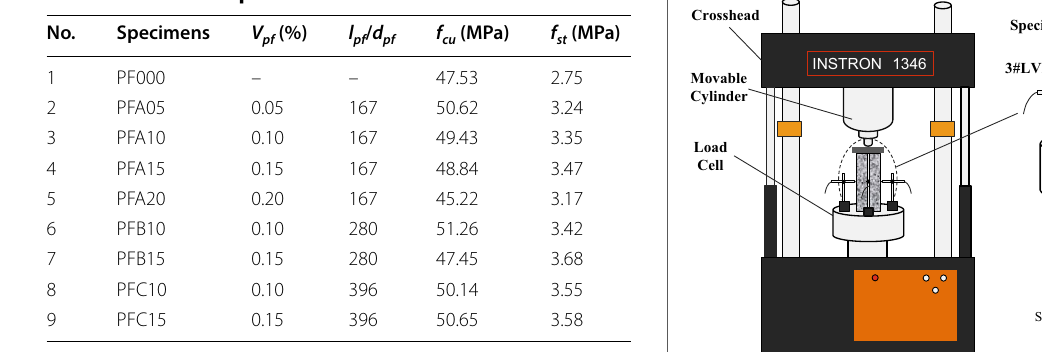
Table 2 Details of specimens.